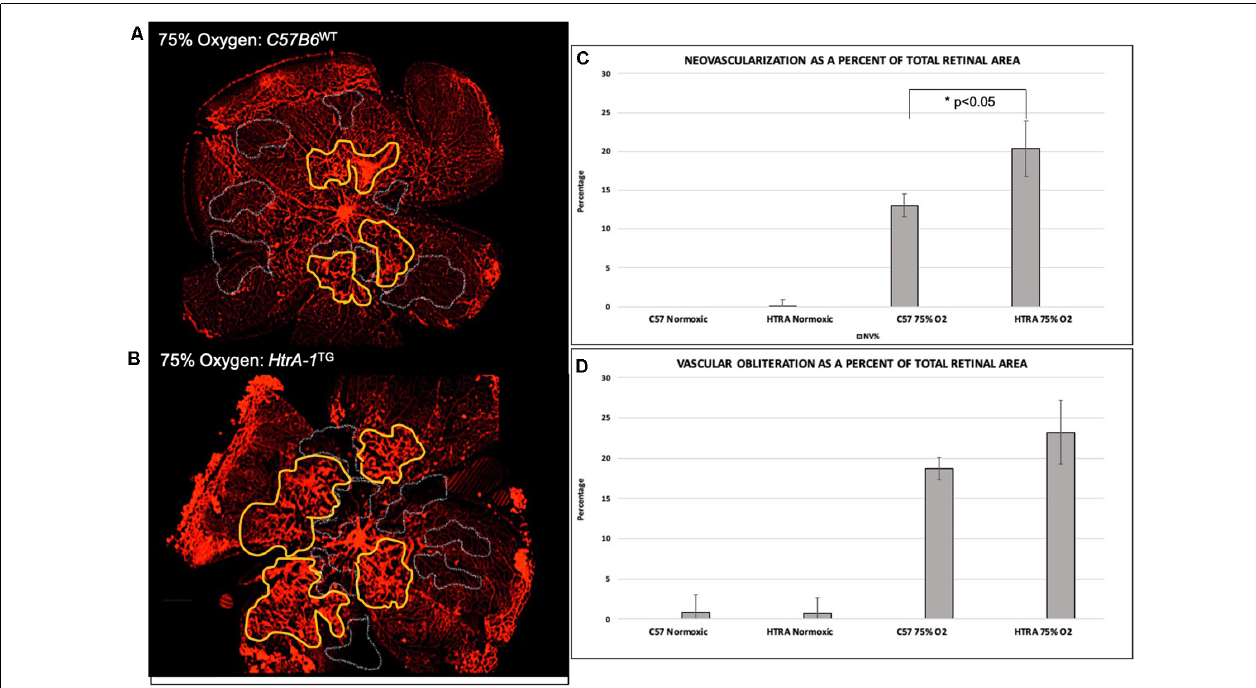
FIGURE 2 | Transgenic mice over-expressing HtrA-1 demonstrate greater severity of neovascularization in the oxygen-induced retinopathy (OIR) model. HtrA-1Tg or Wild-type C57B6 mice were placed under OIR or RA conditions ( n = 8 mice per genetic background per condition). (A,B) Neovascularization (NV) and vascular obliteration (VO) were assessed using Isolectin-594 staining of flat-mount images. Representative areas of NV and VO have been highlighted in yellow and gray respectively. (C,D) Quantification of NV (C) and VO (D) was done using masked tracings of the neovascular retina, avascular retina, and total retinal area such that NV and VO were quantified relative to the total retinal